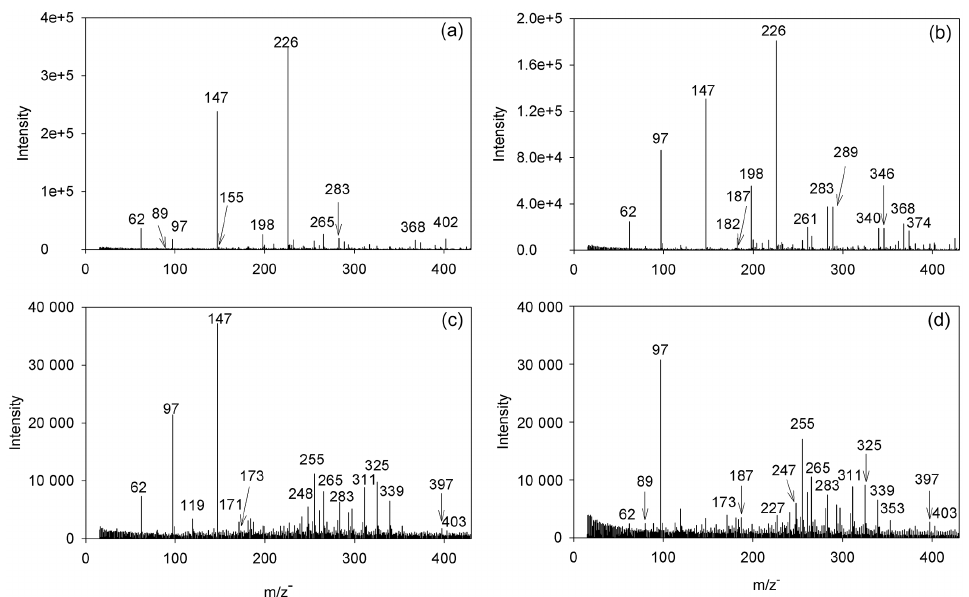
Figure 1. Negative-mode mass spectra for 3h irradiated AS aerosols (a) and SA aerosols (b) in the humid chamber, and AS aerosols (c) and SA aerosols (d) in the dry